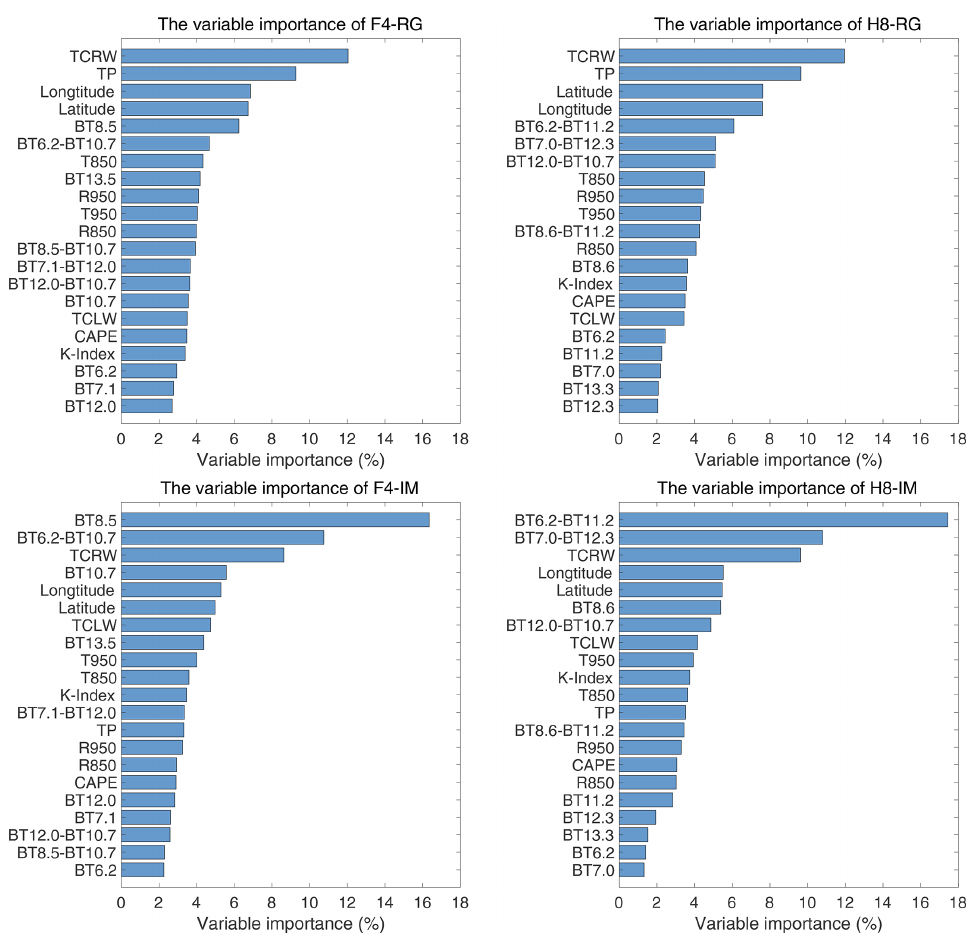
suitable for the predictand than IMERG data when using ML to predict surface